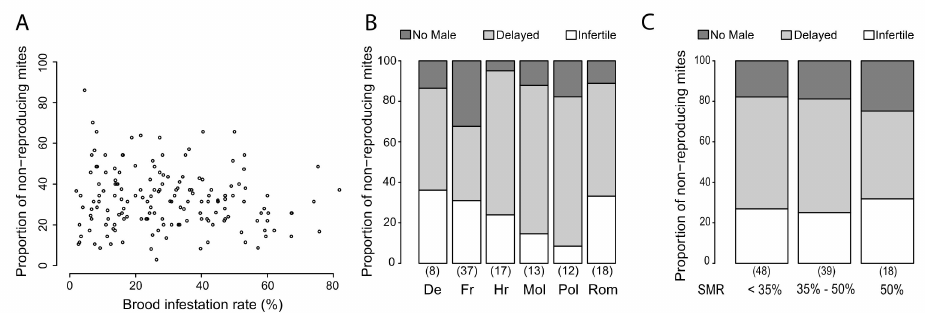
Figure 6. Putative mechanisms for SMR. ( A ) Relationship between brood infestation rates and SMR scores ( n = 159). ( B ) Analyses of causes for non-reproduction ( n = 105) according to the country, and ( C ) according to the level of the SMR score. N-values are indicated below each